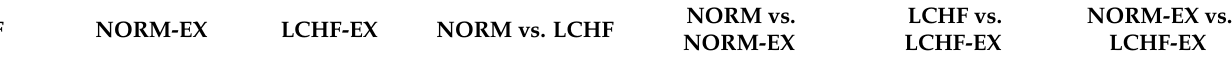
NORM vs. LCHF vs. NORM-EX vs. NORM-EX LCHF-EX LCHF-EX Between Group Differences at Baseline vs. Post Intervention ( p -Values)